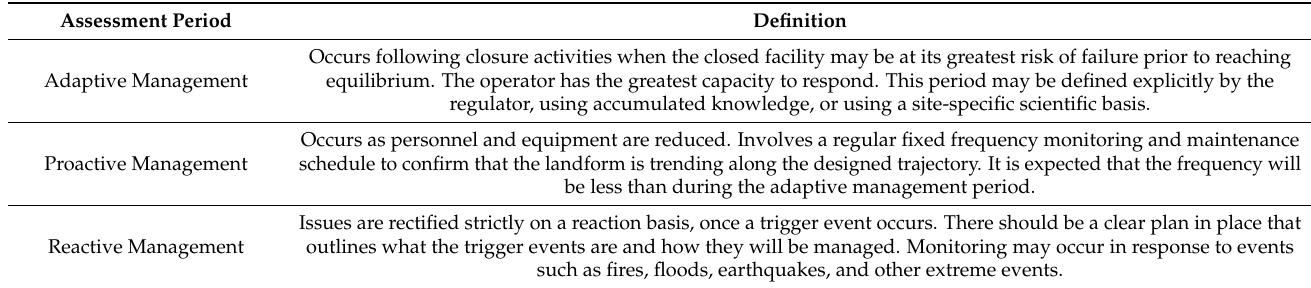
Table 3. Assessment periods [44].